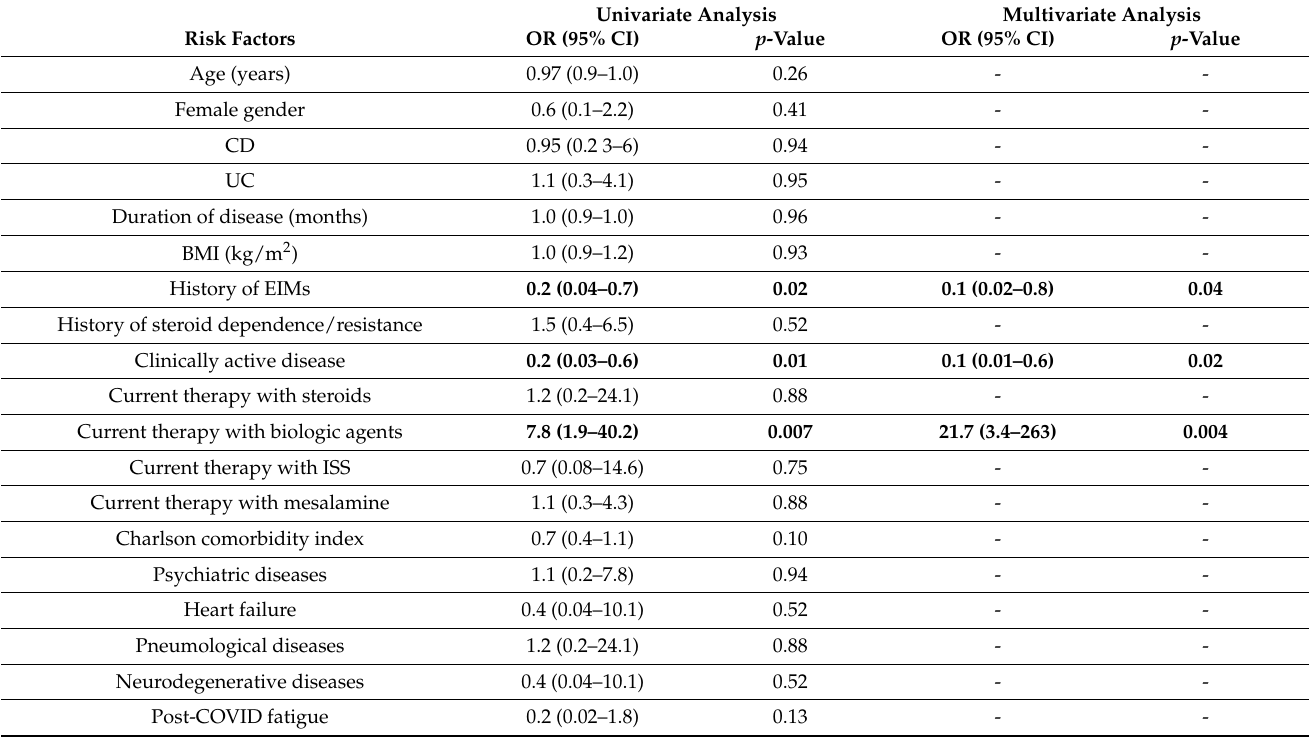
Table 4. Predictive factors for improvement of frail phenotype at the end of the study. OR: odds ratio; CI: confidence interval; CD: Crohn’s disease; UC: ulcerative colitis; BMI: body mass index; EIMs: extraintestinal manifestations; ISS: